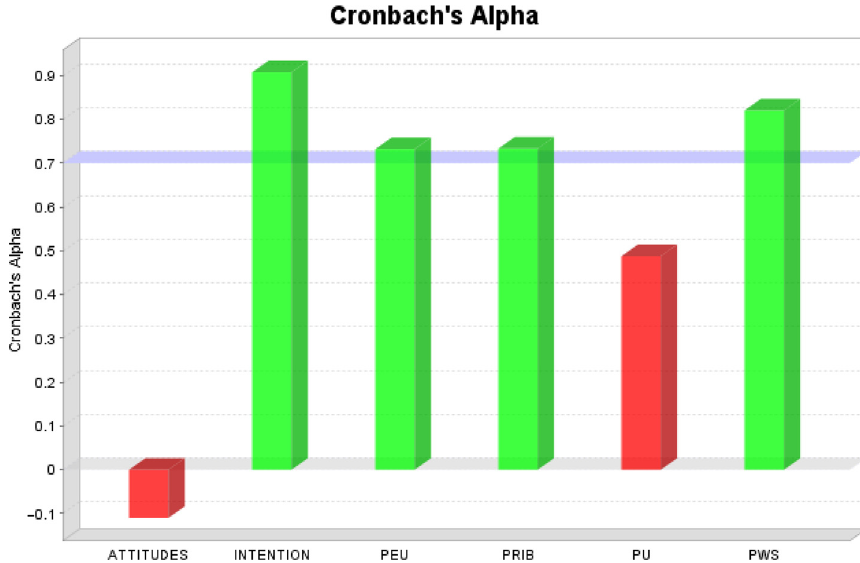
Figure 4. Cronbach ’ s alpha for internet banking users ’